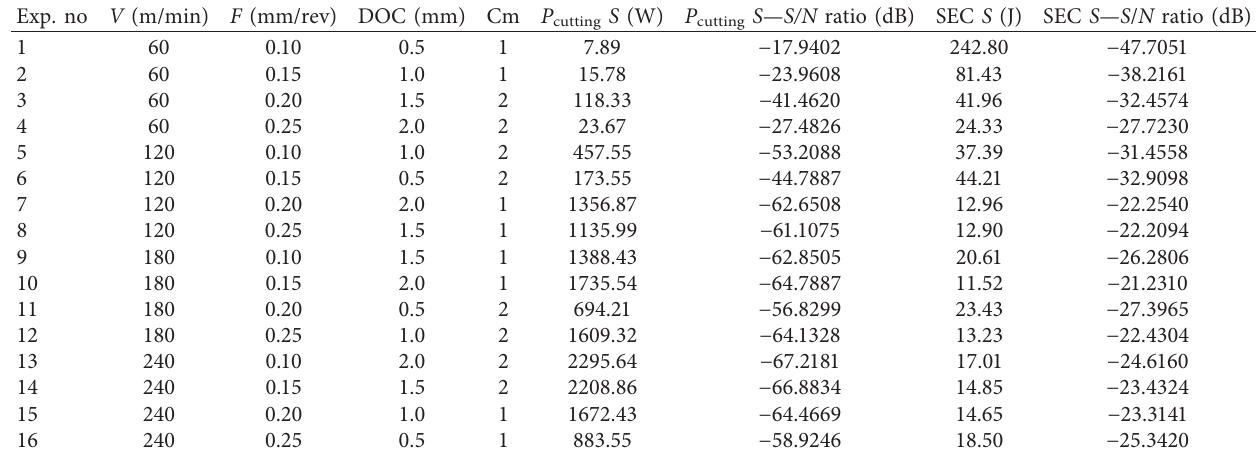
Table 4: Experimental energy consumption results and S / N